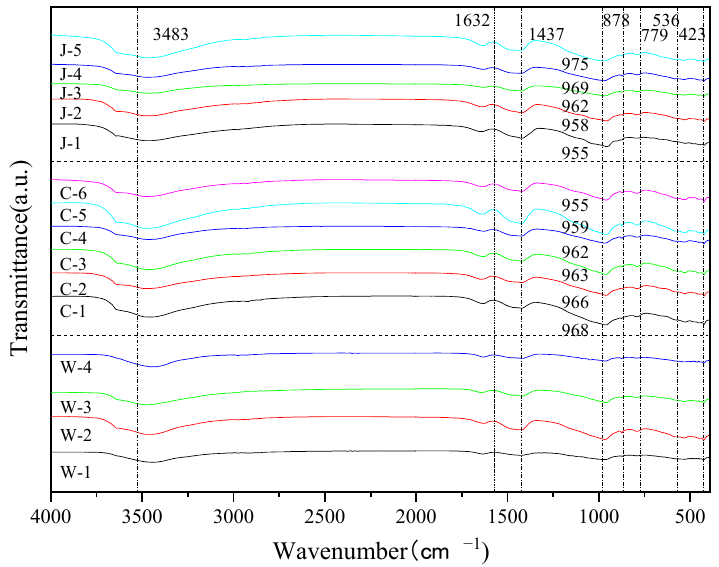
Figure 5. FTIR curves of all 28 d net slurry specimens at different groups.